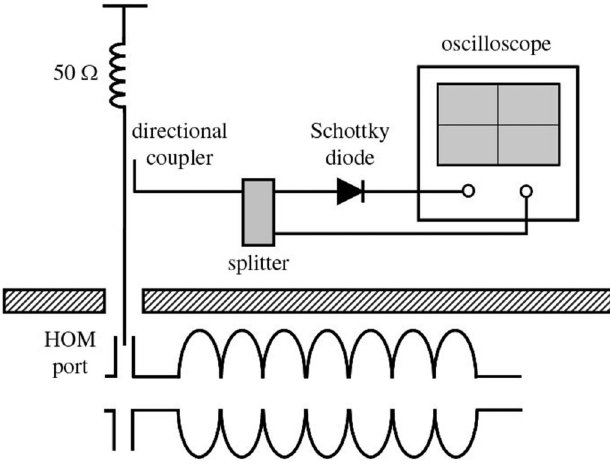
neously measuring the HOM power and voltage from a particu- lar